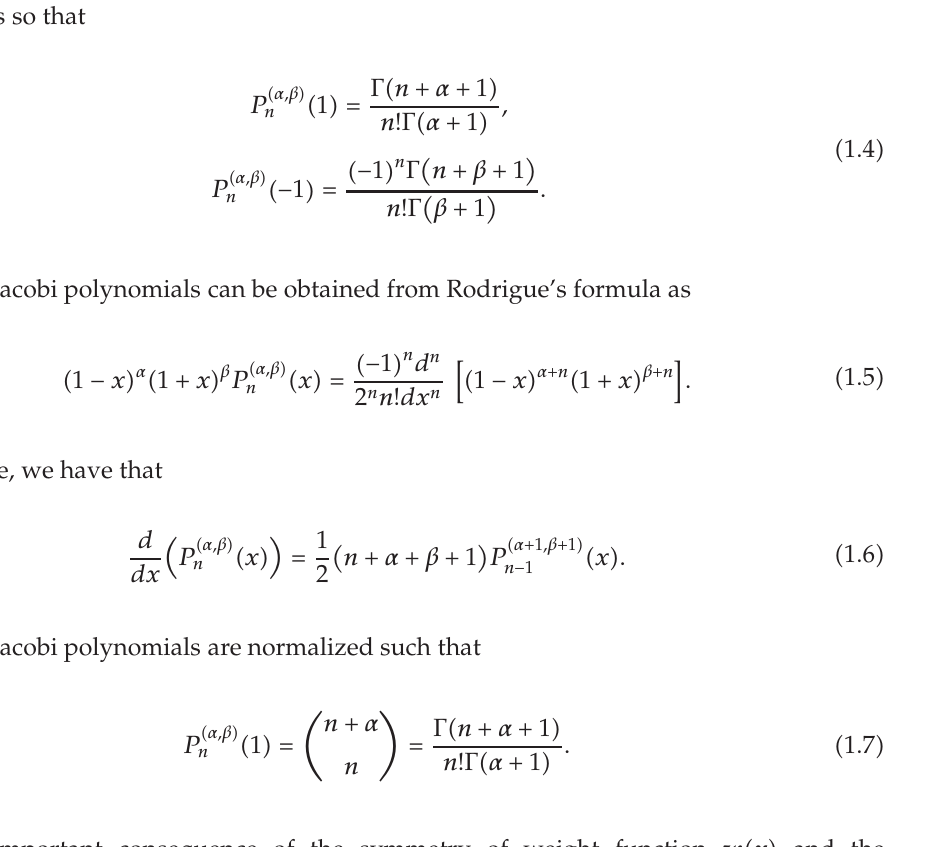
Table 1: The roots of P